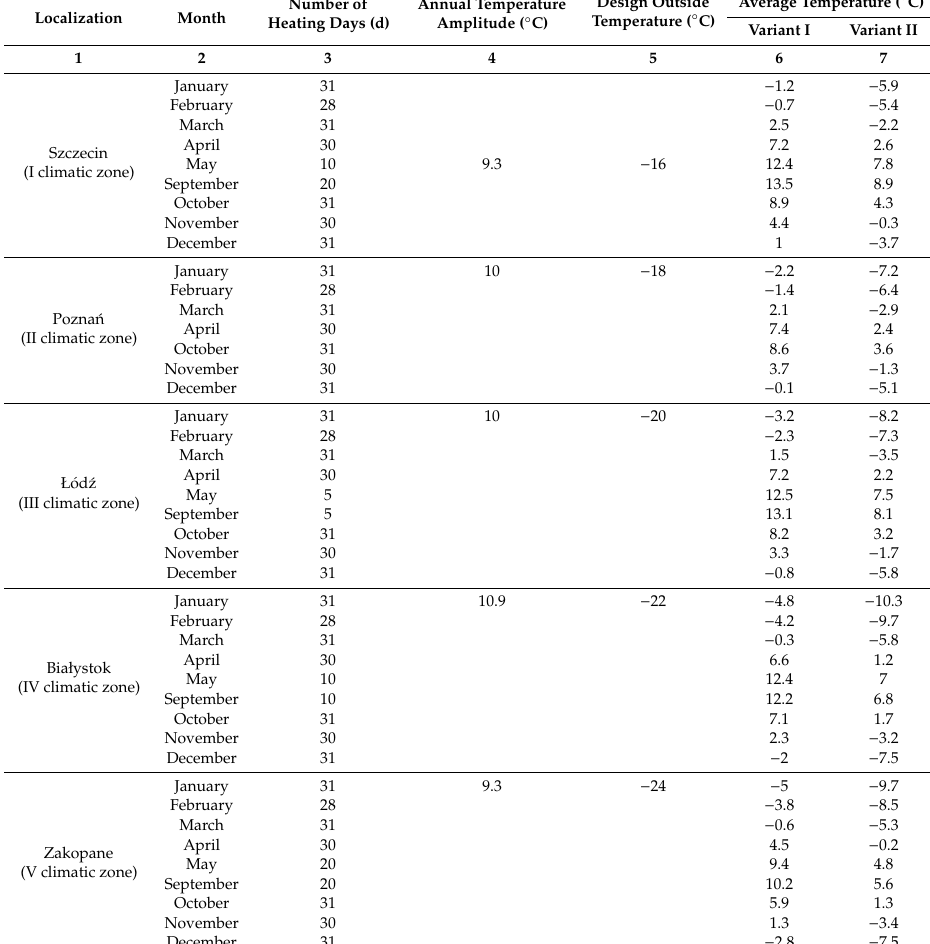
Table 2. Information on the climatic conditions in the analyzed localizations